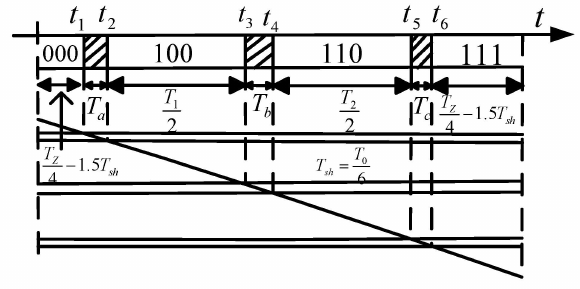
Figure 6. Diagram of improved PWM scheme for ZSI.